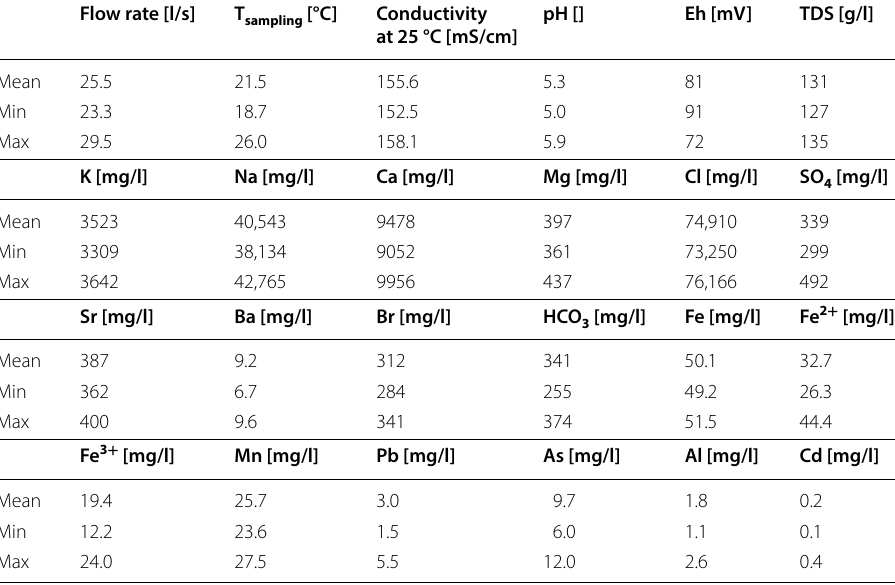
Mean values are based on the analysis of 32 samples